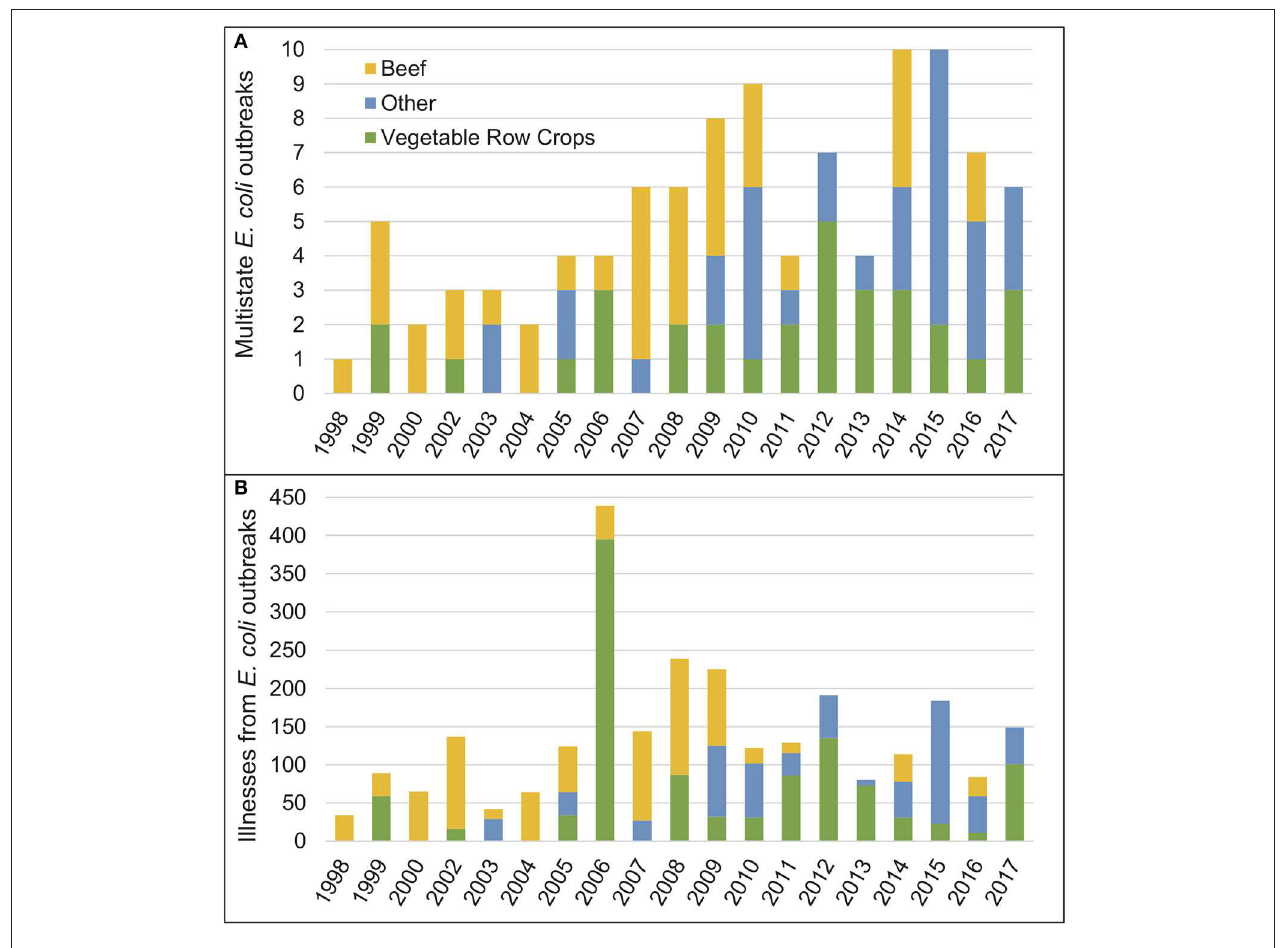
FIGURE 1 | (A) Number of multistate E. coli outbreaks linked to a food source in the US, 1998–2017. (B) Number of illnesses resulting from multistate E. coli outbreaks linked to a food source in the US, 1998–2017. For both charts, source attribution follows Interagency Food Safety Analytics Collaboration (IFSAC) categories identified in the NORS database. For simplicity, all IFSAC categories other than beef and vegetable row crops (the two largest single categories) are combined into a single “Other” category. CDC, National Outbreak Reporting System (NORS), https://wwwn.cdc.gov/norsdashboard/, accessed July 17,